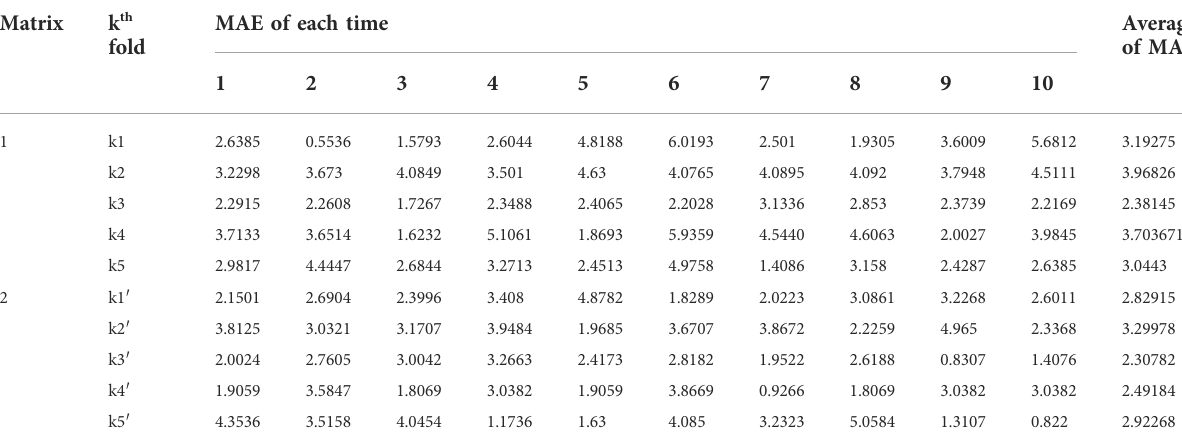
TABLE 5 Selection of training models.